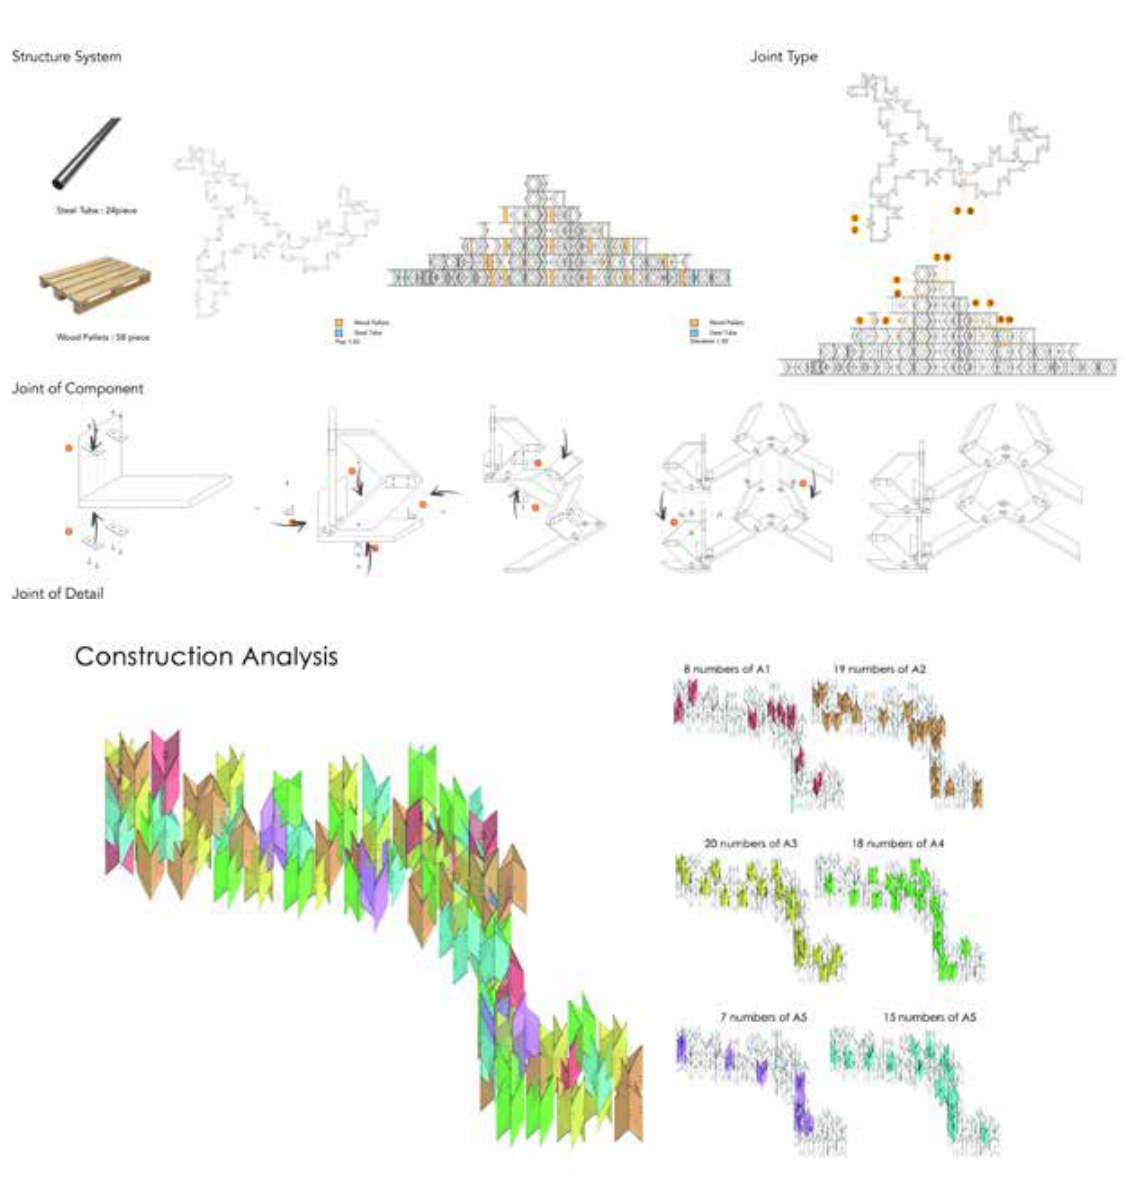
Figure 4 (top): Design concept of the component and the installation. Source: author. Figure 5 (bottom): Organisation diagram of the six variations of the component. Source: author.